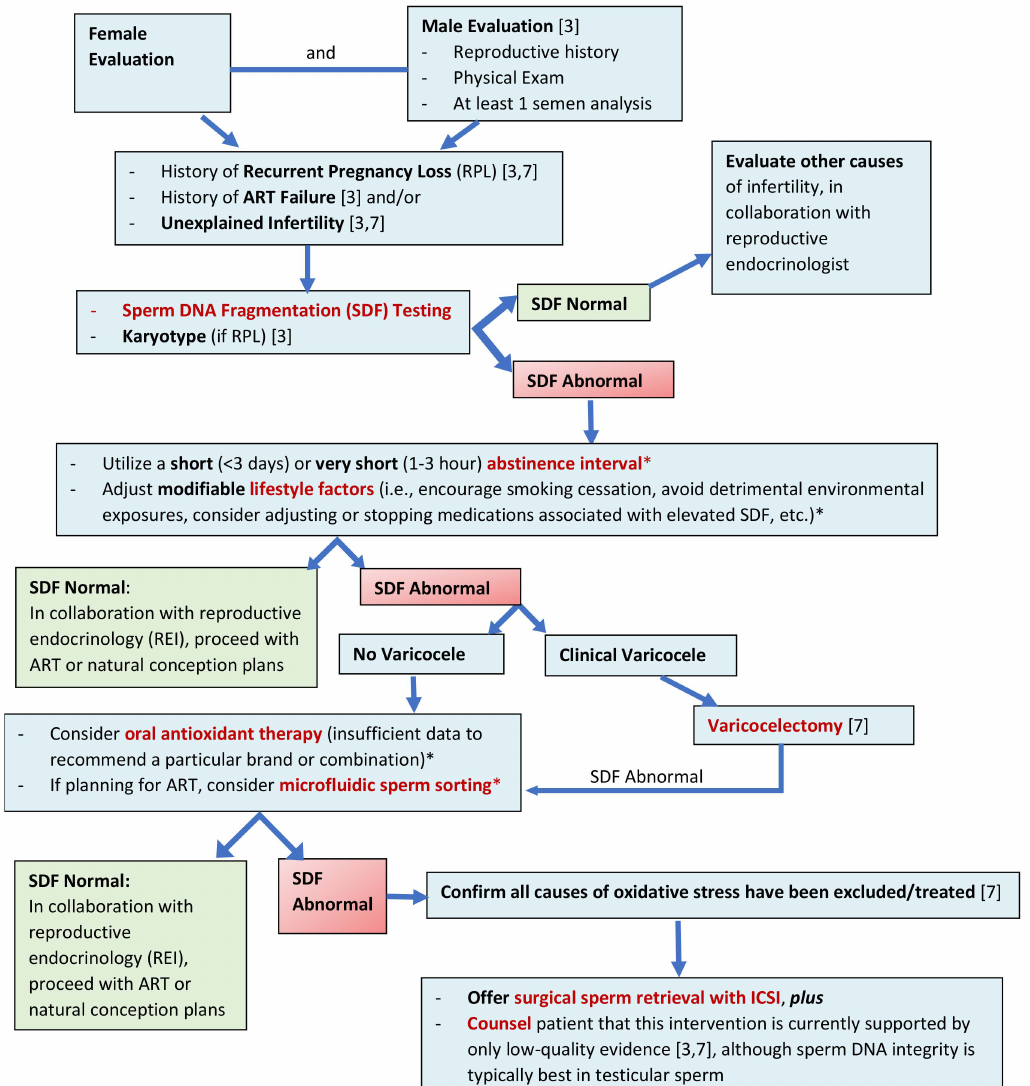
Figure 1. An Evidence-Based Approach to the Evaluation and Management of an Infertile Couple with Elevated Sperm DNA Fragmentation (SDF). ( * = Interventions supported by current literature but not explicitly supported by current AUA/ASRM or EAU guidelines. References [3,7] refer to AUA/ASRM and EAU guidelines,